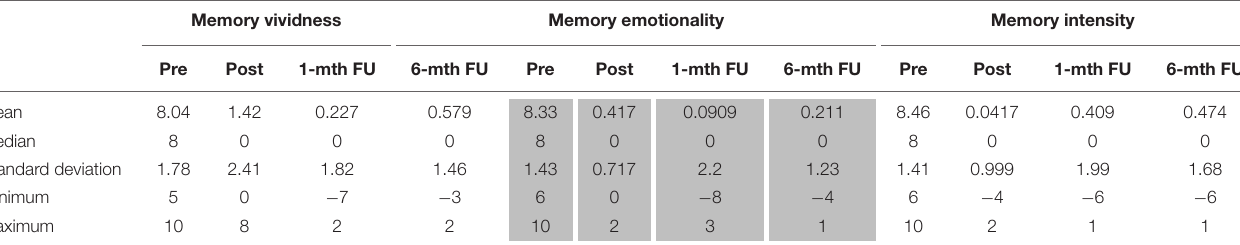
TABLE 4 | Descriptives – memory vividness (MV), memory emotionality (ME), and memory intensity (MI): pre, post, 1-month, and 6-month FUs ( N = 24).